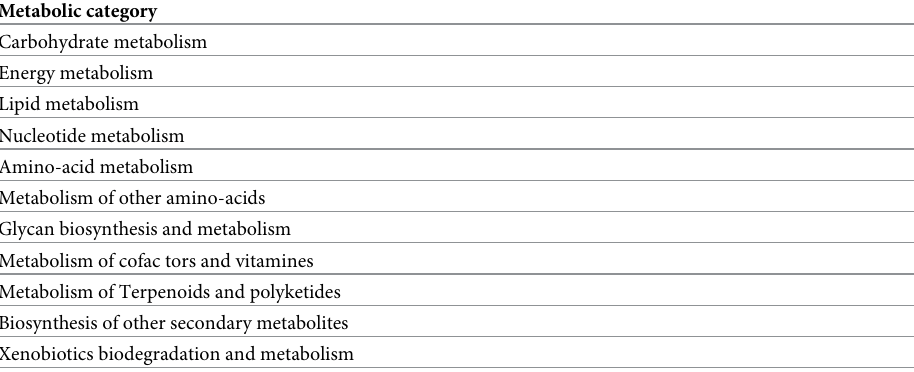
Table 1. List of KEGG metabolic categories: Each one is composed by many metabolic pathways.